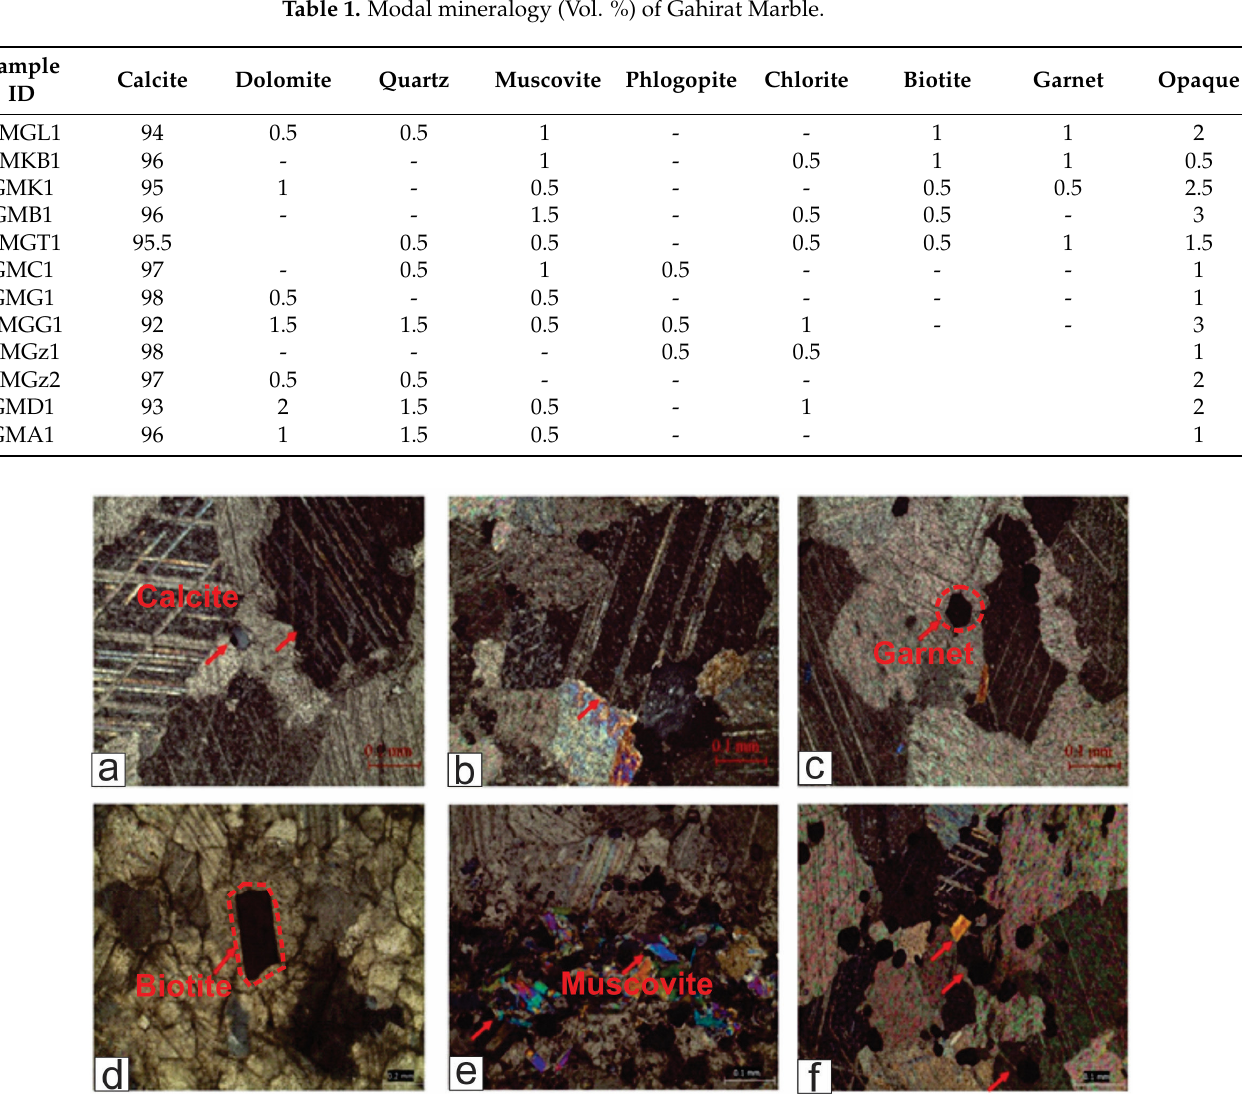
Figure 3. Photomicrograph of Gahirat Marble: ( a ) large crystals of calcite (cal) having very few micro fracture GMGL1, ( b ) calcite grains showing twin lamellae having homoplastic texture with few traces of ore mineral GMKB1, ( c ) shows both visible and invisible twin lamellael grains of calcite in GMK1, ( d ) shows large interlocking crystals of calcite with biotite mica with significantly less fracture grain GMB1, ( e ) the muscovite grains showing alignment in two direction twin lamellae GMA2 showing minor fractures in calcite crystal, ( f ) showing garnet grains between the calcite GMGT1.